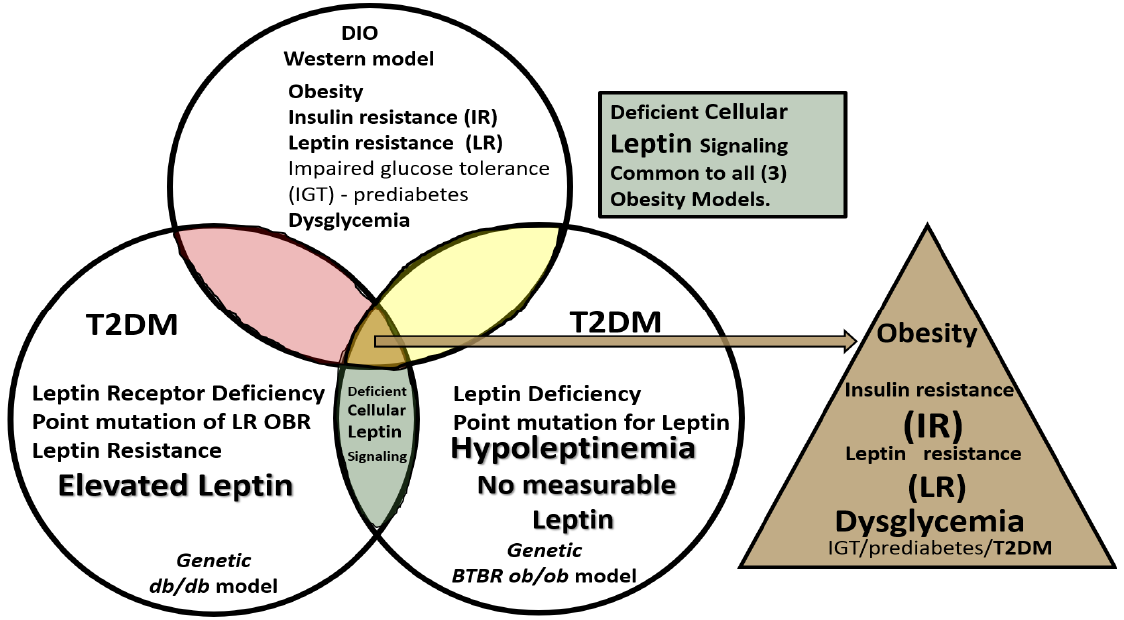
Figure 3. Venn diagram illustrates the shared importance of leptin in diet-induced obesity (DIO), Western, db/db and BTBR ob/ob models. Deficient cellular leptin signaling is common in all three models, but through different mechanisms. All models are obese and there is dysglycemia in the diet induced obesity (DIO) model, overt T2DM in the db/db , and elevated blood glucose levels in the BTBR ob/ob. IGT = impaired glucose tolerance; IR = insulin resistance; LR = leptin resistance; T2DM = Type 2 diabetes mellitus.